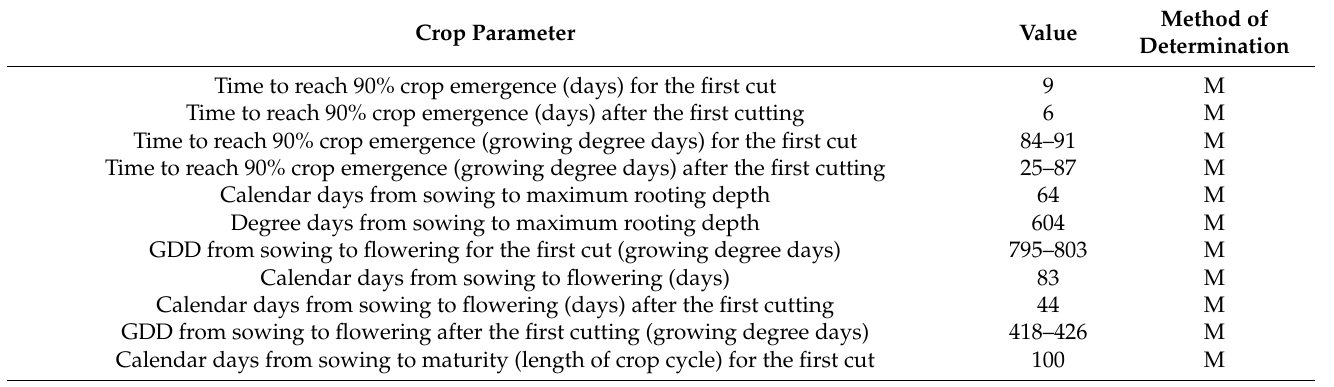
Table 6. Detailed AquaCrop Ryegrass ( Lolium perenne L.): non-conservative and/or cultivar- specific